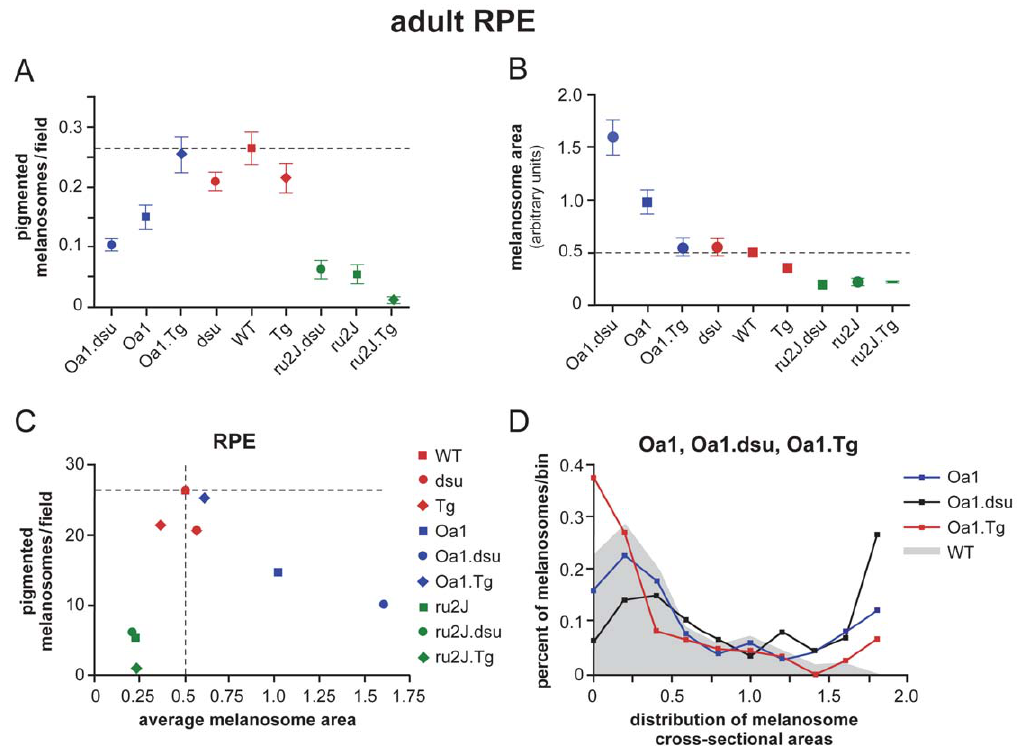
Figure 3. Melanosome density, cross sectional area, and size distribution exhibit a dosage-dependent effect of melanoregulin in the Oa1 null mouse. Quantitation and analysis of the data shown in Figure 2. Data points are mean values 6 SEM. Note the nearly inverse linear relationship between melanoregulin expression and A. Melanosome number and B. Melanosome area on an Oa1 null background. On an Oa1 background, both melanosome number and area show a statistically significant change as a function of melanoregulin expression, with p , 0.05 as indicated by asterisks (*). No statistically significant difference was observed in Hps5 ru2J mice, p . 0.05. Mreg dsu mice show a significant decrease in number of melanosomes, p , 0.05 with no change in melanosome area, p . 0.05. . C. The number of pigmented melanosomes per field is compared to the average melanosomal area in wildtype (C57BL6/J) mice. Abbreviations: ru2J=Hps5 ru2J ; dsu=Mreg dsu ; WT=wildtype; Tg=Mreg Tg ; Oa1=Oa1 ko .